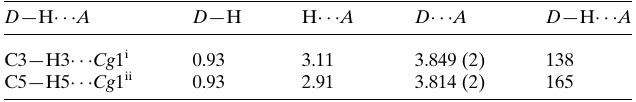
Table 1 C—H (cid:2)(cid:2)(cid:2) (cid:2) interactions (A˚ , (cid:3) ). Cg 1 is the centroid of the C1–C6 benzene ring.